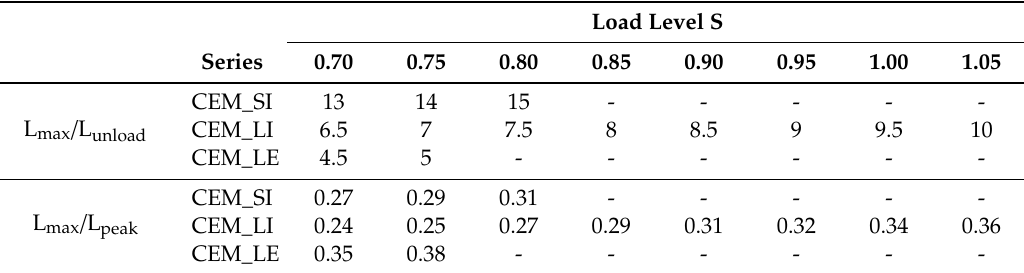
Table 7. Comparison between the load-bearing capacity of the intact self-healing specimens and their residual load-bearing capacity after pre-cracking with the applied maximum load in cyclic